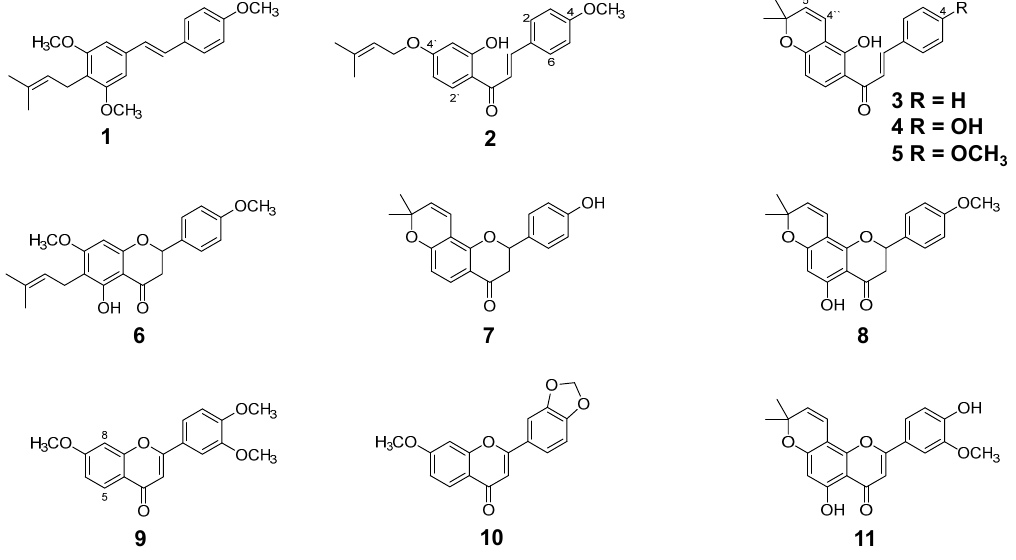
Figure 1. Chemical structures of isolated flavonoids from D. duckeana .